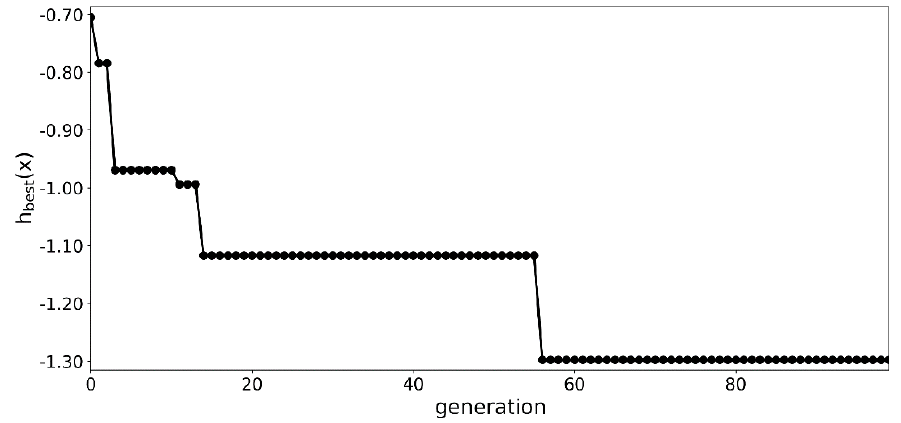
Figure 3. Value of the best fit specimen over the generations.